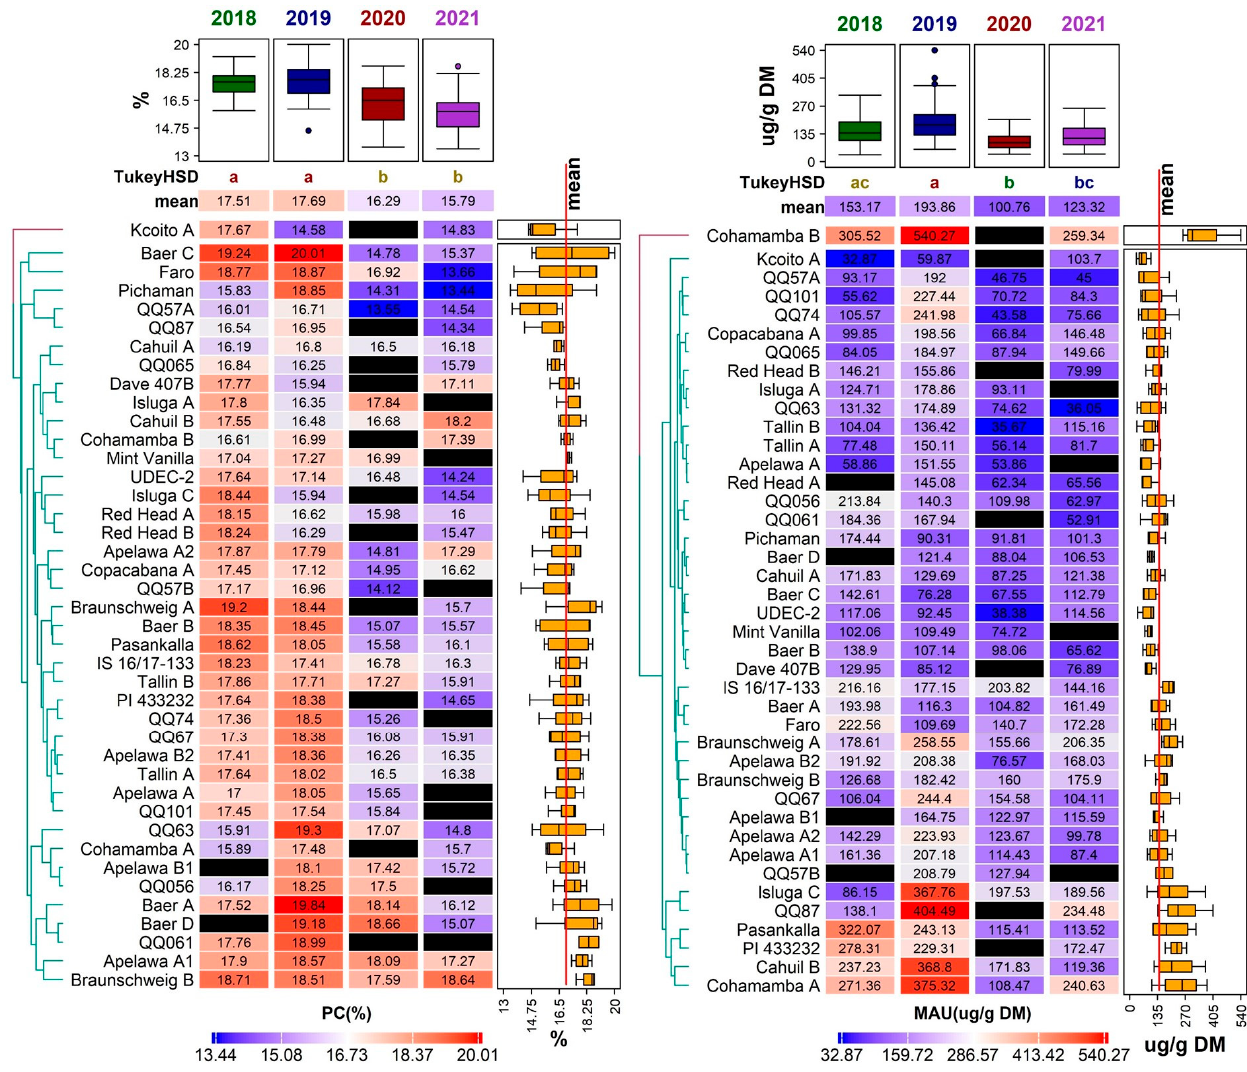
Figure 5. Diversity of the 41 quinoa genotypes in terms of protein content (PC, ( left )) and mauritianin content (MAU, ( right )) values, illustrated using a heatmap combined with a dendrogram based on average linkage clustering of Euclidean distance dissimilarity matrix values for the respective traits, displayed on a scale from blue (min) to red (max) according to the color key below each heatmap. Black rectangles indicate missing values for a given trait in a given genotype. Years with significantly different means are denoted by the different letters (Tukey HSD) above the individual columns of the respective heatmaps. Boxplots above each heatmap show the distribution of values across all accessions in individual years, while the boxplots next to each heatmap show the distribution across all years for individual accessions. The quality of representation of the variables is shown in the factor map.